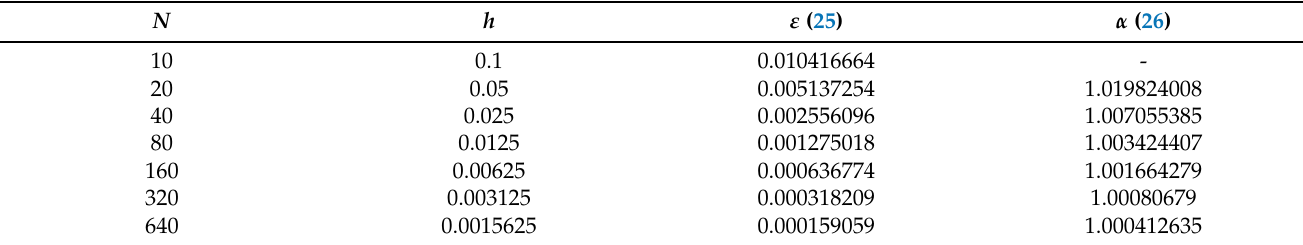
Table 1. Error and computational accuracy of the numerical scheme